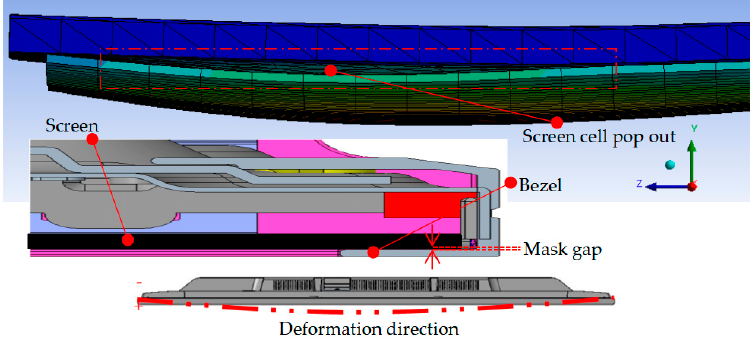
Figure 16. Design